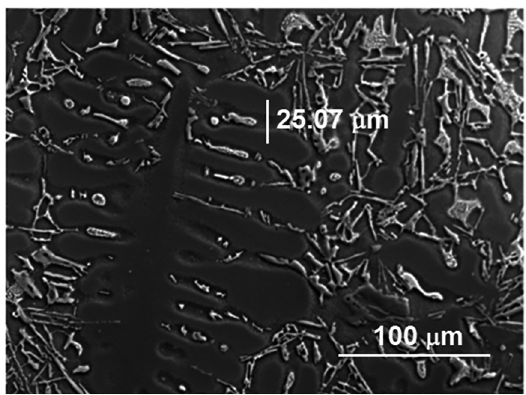
Figure 2. Track adopted for microsegregation profiles in dendritic arm of a ternary Al-9.0wt%Si-4.0wt%Cu alloy.